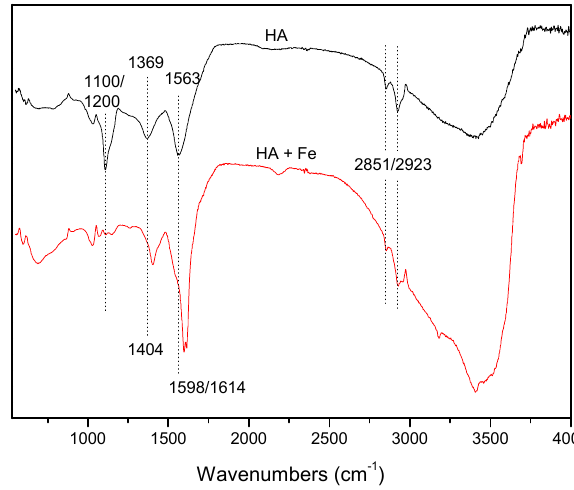
Figure 6. FTIR spectra of HA and HA + Fe. The black curve represents spectrum of HA, and the red curve represents the spectrum of HA + Fe with the corresponding concentrations of 5 mg L − 1 HA and 100 μ mol L − 1 Fe(III).